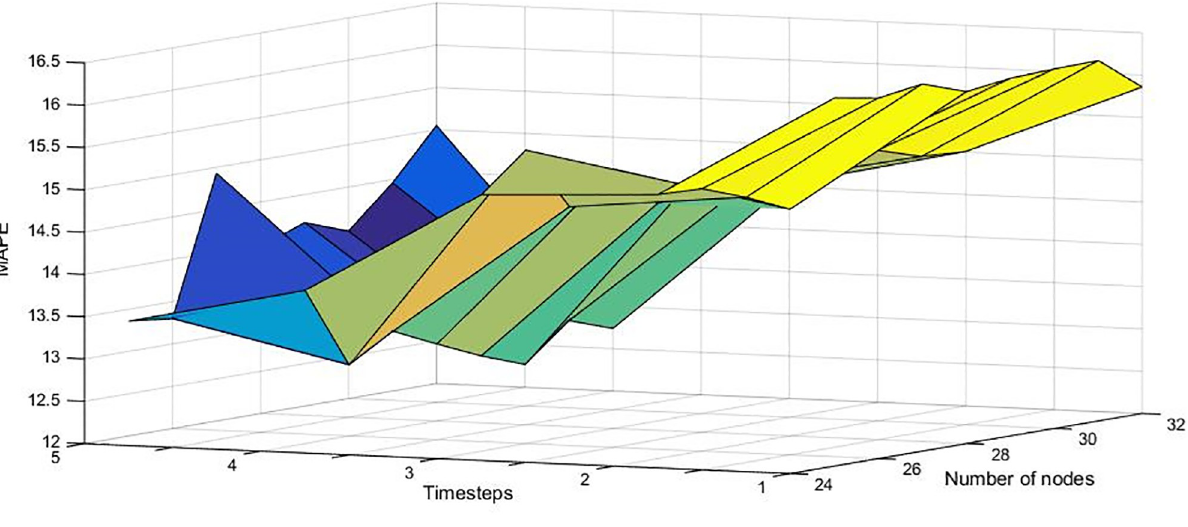
Fig 2. Results of grid search for